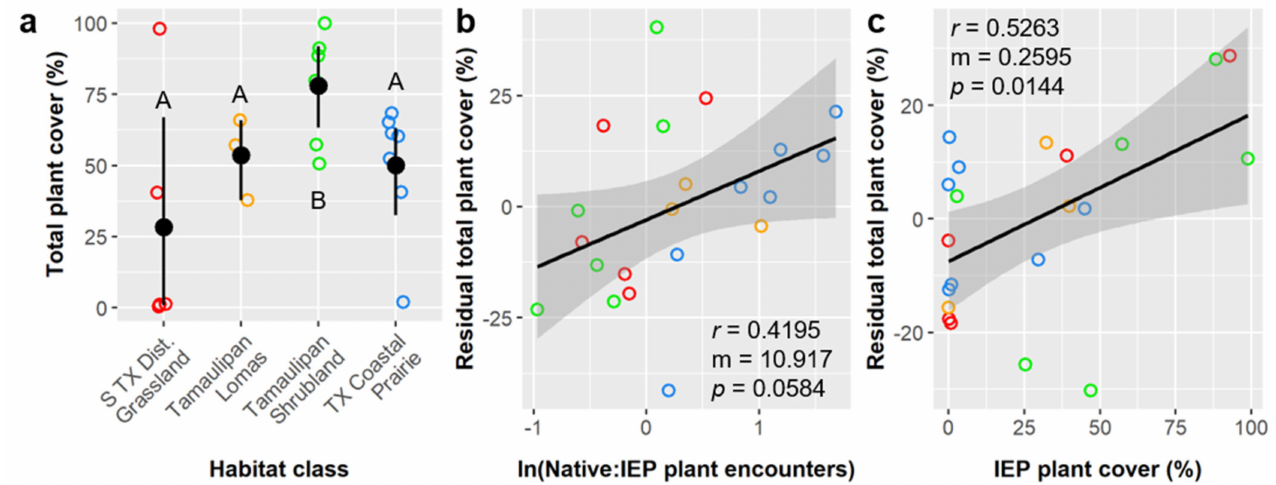
Figure 6. ( a ) Treatment means with 95% confidence intervals showing the effects of habitat class on total plant cover, and the linear relationships between residual total plant cover and ( b ) the natural log of the ratio of native to IEP plant encounter rates and ( c ) IEP plant cover. Open circles denote values from one study site and are colored to denote habitat class as follows: red, S TX Disturbed Grassland; orange, Tamaulipan Lomas; green, Tamaulipan Shrubland; blue, Texas Coastal Prairies. Legend: r , Pearson correlation coefficient; m, slope from the regression model (effect size); p , p -value from the regression model (see Table S6 for p -values from the ANCOVA model). Capital letters in panel a denote results of least square means post hoc tests; groups that share a letter were not significantly different.